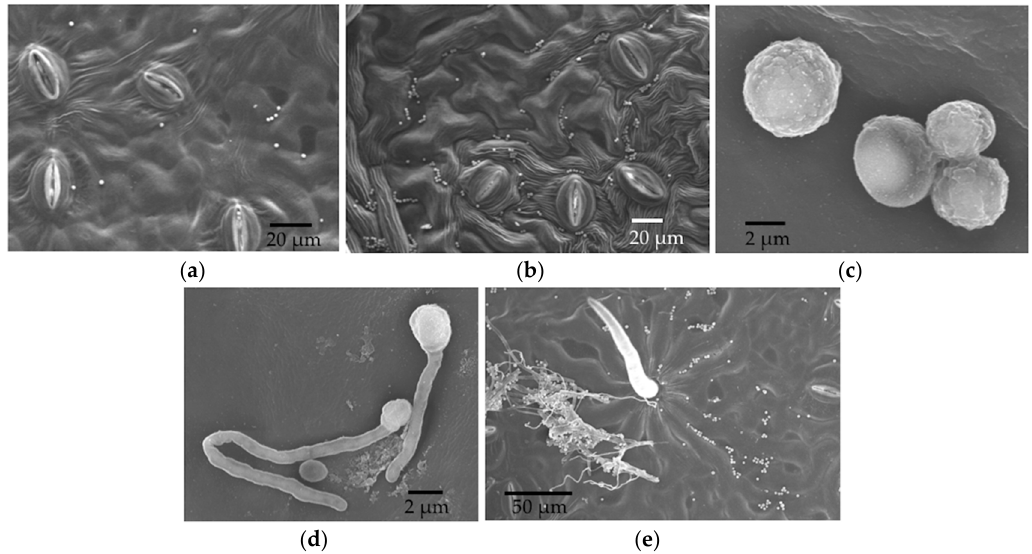
Figure 5. SEM photos from the in vitro inoculation of leaf discs of P. trichocarpa with an endophytic strain of Penicillium citrinum 0079. ( a ) Low magnification view of lower epidermis, six HAI; ( b ) Non-germinated conidia are dispersed on lower epidermis, 24 HAI; ( c ) Non-germinated conidia at high magnification, 24 HAI; ( d ) Germinated and non-germinated conidia at high magnification, 48 HAI; ( e ) Germinated conidia and hyphae, as well as non-germinated conidia, on lower epidermis, 48 HAI.